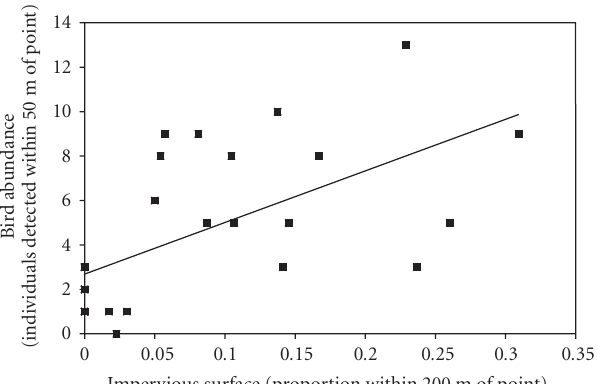
Figure 3: Abundance of birds increased with increasing exurban- ization. The number of individual birds (regardless of species) detected during 5 minute point counts was higher at points that had higher proportions of impervious cover around them (linear regression, P = .0003, R 2 = 0.38, df = 1,27).